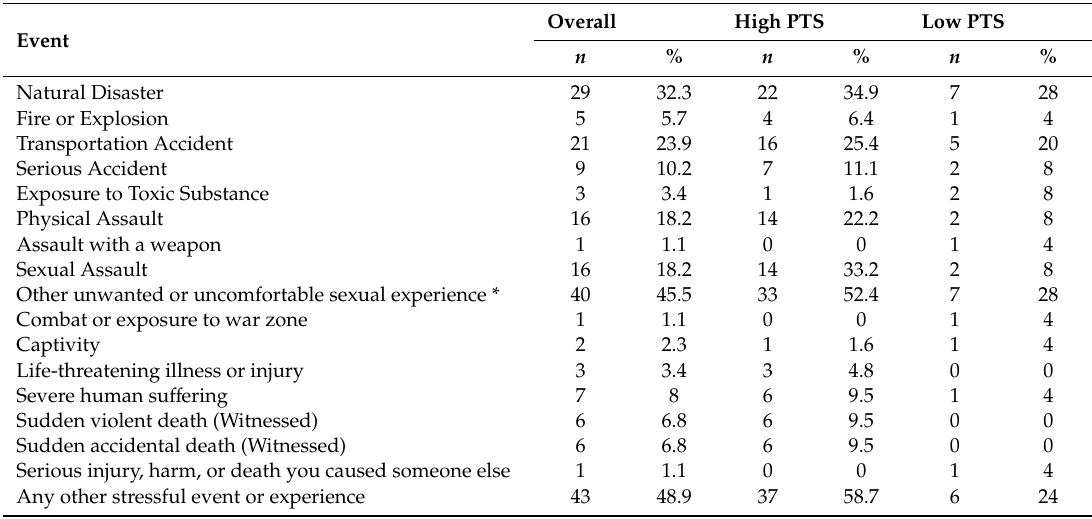
Table 3. Frequencies of potentially traumatic events for all participants, participants with high PTS, and participants with low